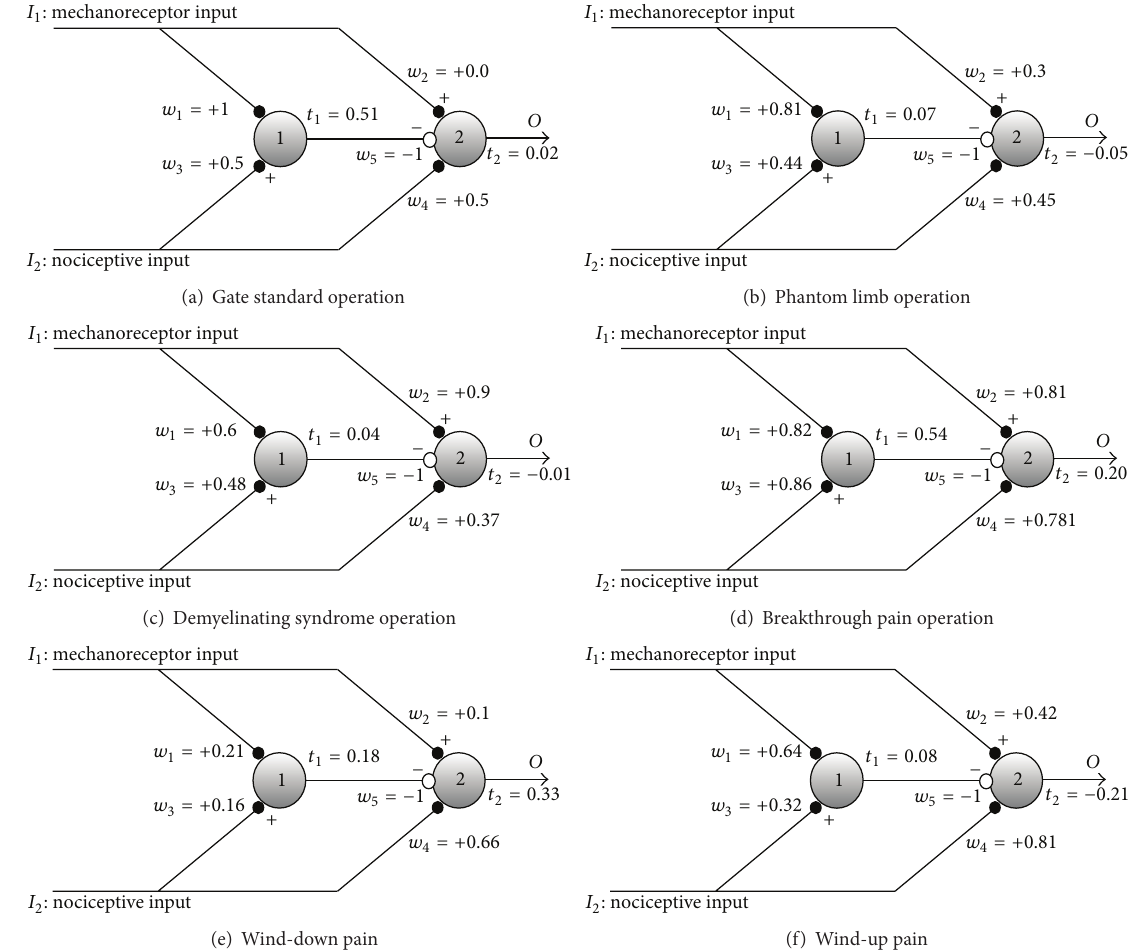
Figure 12: Synaptic weights and firing threshold values when the gate circuit arrives to stability for the different cases previously explained. When placing the different type of inputs in the gate circuit, neuron 2 response is according to the type of response expected in each case. In the case of graph (b), we considered the parameters of gate circuit that only produces phantom pain when no inputs at all enter the gate (see Figure